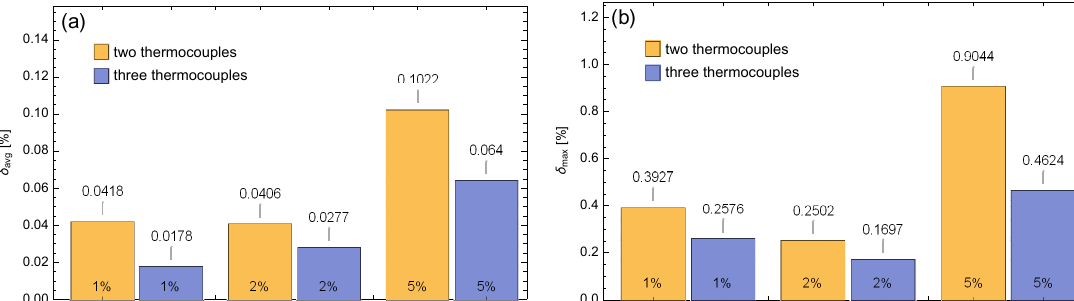
Figure 8. Comparison of ( a ) mean and ( b ) maximum relative errors of temperature reconstruction in the control points in case of calculations executed for data taken from two and three thermocouples (one step